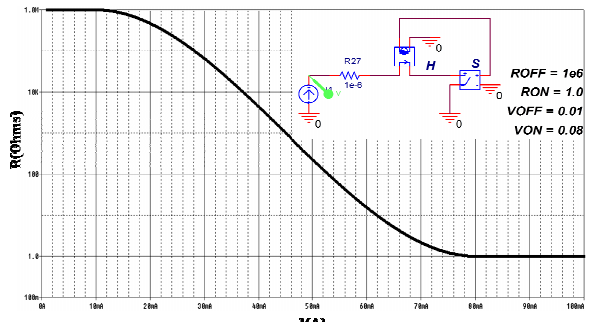
Figure 12: Basic of the “diode” model